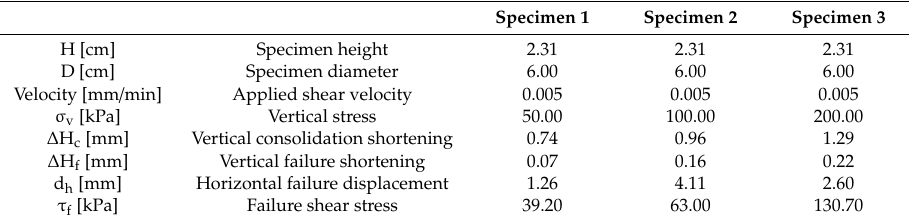
Table 1. Direct shear test and specimens details.